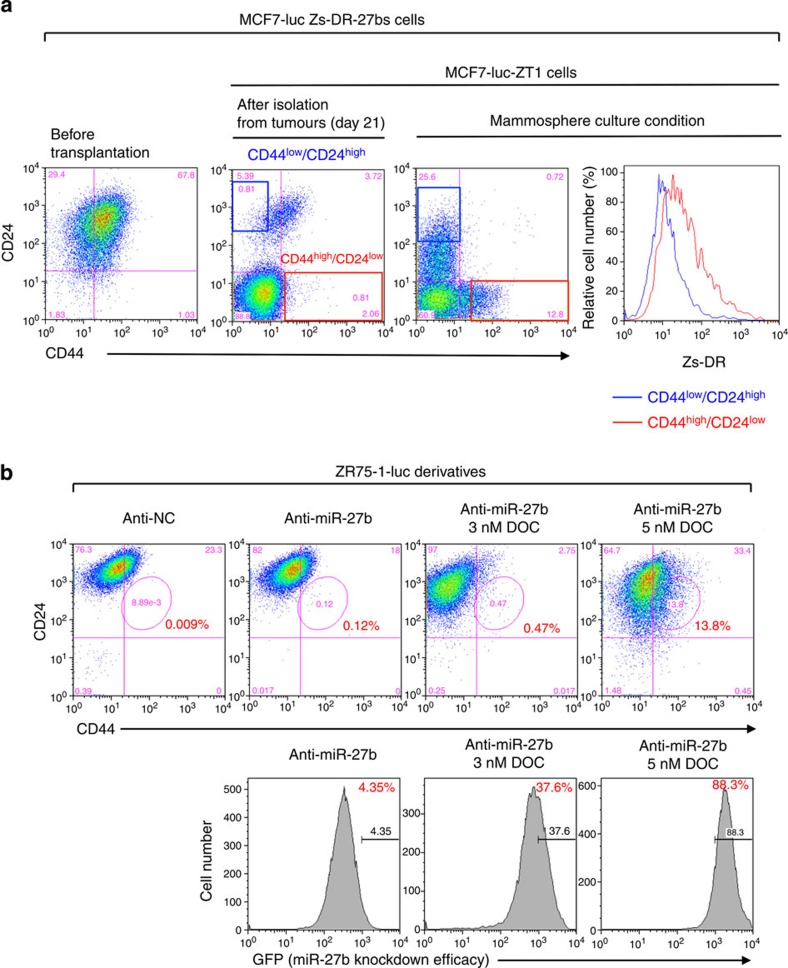
Downregulation of miR-27b is associated with the generation of CD44high/CD24low fraction.(a) Flow cytometry analyses of the CD44high/CD24low population and Zs-DR expression in MCF7-luc Zs-DR-27bs and its tumorigenic cells (MCF7-luc-ZT1 cells) in adherent and mammosphere culture conditions. (b) Flow cytometry analyses of the CD44high/CD24low and GFPhigh populations of ZR75-1-luc anti-miR-27b cells treated with docetaxel (DOC).